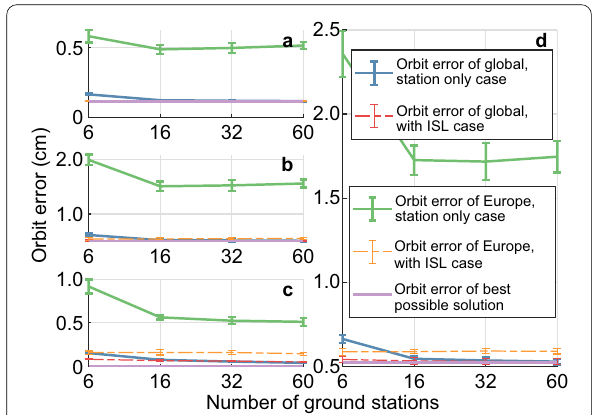
between the number of stations and orbit errors. We chose five global networks containing different number of stations from only 1 station to a maximum of 60 sta- tions. When orbits are determined using the observa- tions only from ground stations, with more stations, the orbit improvement rate becomes smaller. Orbit accu- racy does not benefit much from more than 16 stations.